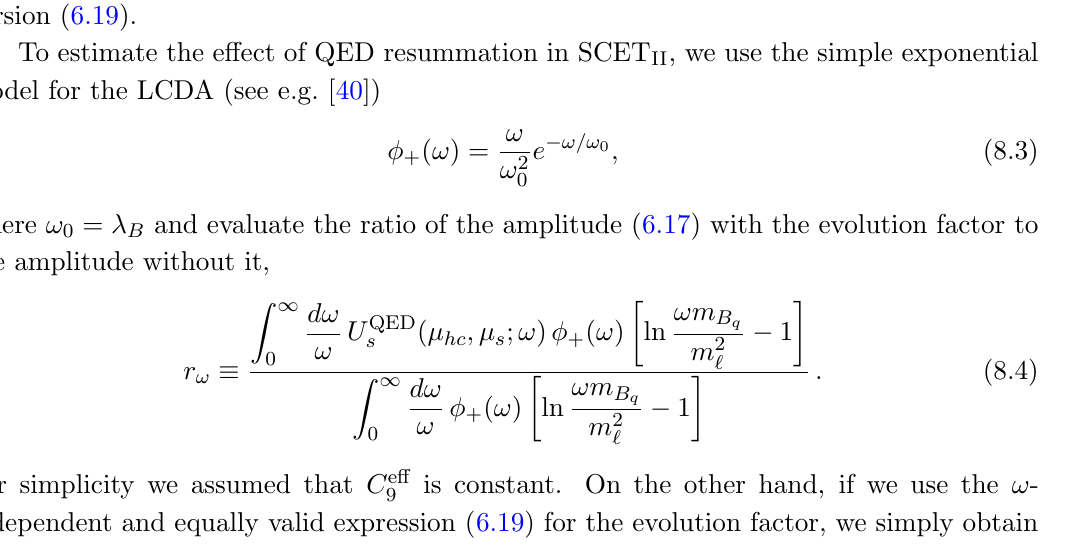
e S q ( (cid:22) b ;(cid:22) hc ) (solid) and e S q ( (cid:22) b ;(cid:22) hc ) (cid:21) B ( (cid:22) hc )